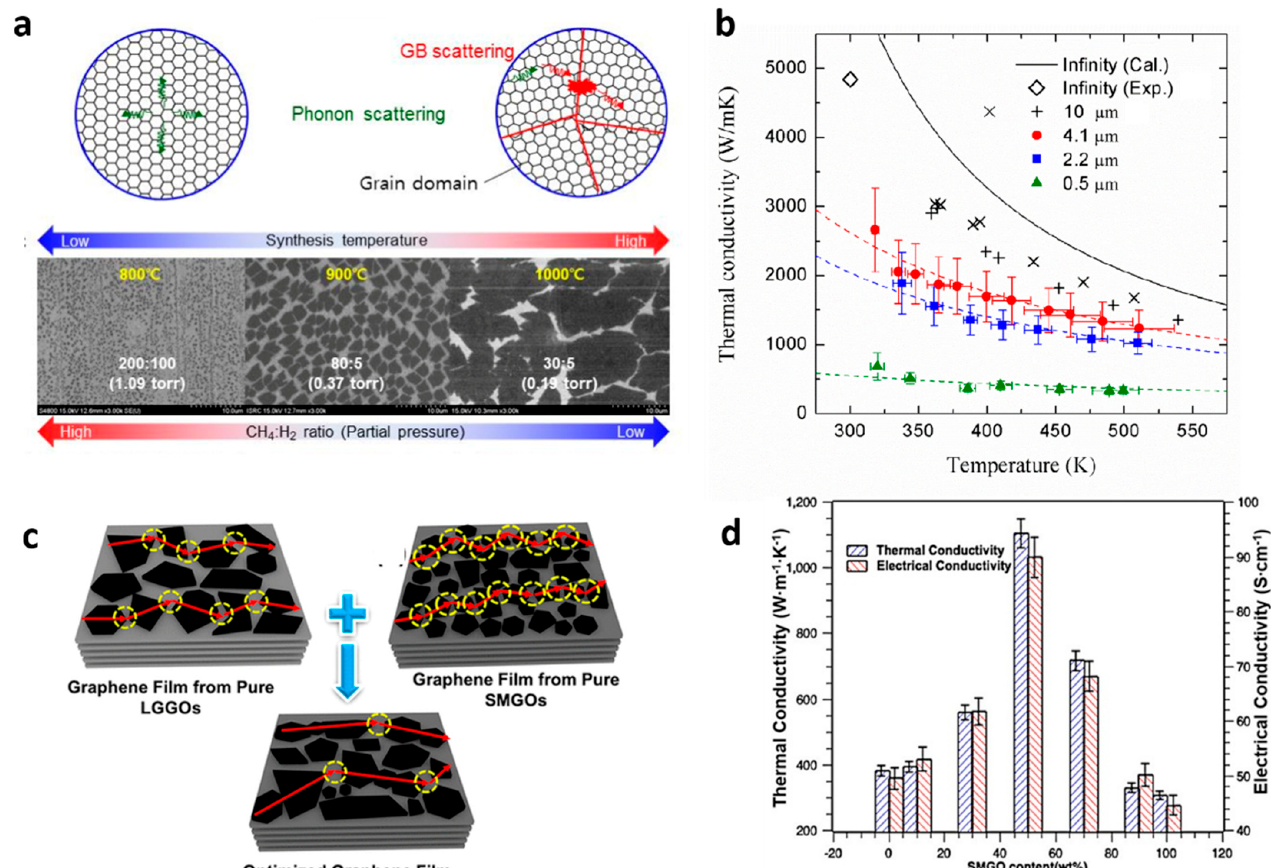
Figure 5. Phonon engineering in graphene. ( a ) Schematic illustration of the scattering mechanisms in polycrystalline graphene, i.e., phonon-phonon scattering and grain boundary scattering, and SEM images of samples with different nucleation densities. ( b ) The k as a function of the measured temperature for suspended graphene samples with grain sizes of 0.5, 2.2 and 4.1 nm. The symbol “ ◇ ” represents the k of exfoliated graphene. The k of “X” were measured for the suspended graphene on the hole of 9.7 μ m in air and the k of “+” were measured for the suspended graphene on the hole of 8 μ m in vacuum condition. ( c ) Schematics of the structure of the graphene films with different sized graphene oxides (large and small size graphene oxide: LGGO and SMGO, respectively) and ( d ) thermal and electrical conductivities of the graphene oxide films with different contents of small-sized graphene oxides (SMGO). ( a , b ) Reproduced with permission from [82]. Copyright American Chemical Society, 2017. ( c , d ) Reproduced with permission from [89]. Copyright American Chemical Society, 2020.